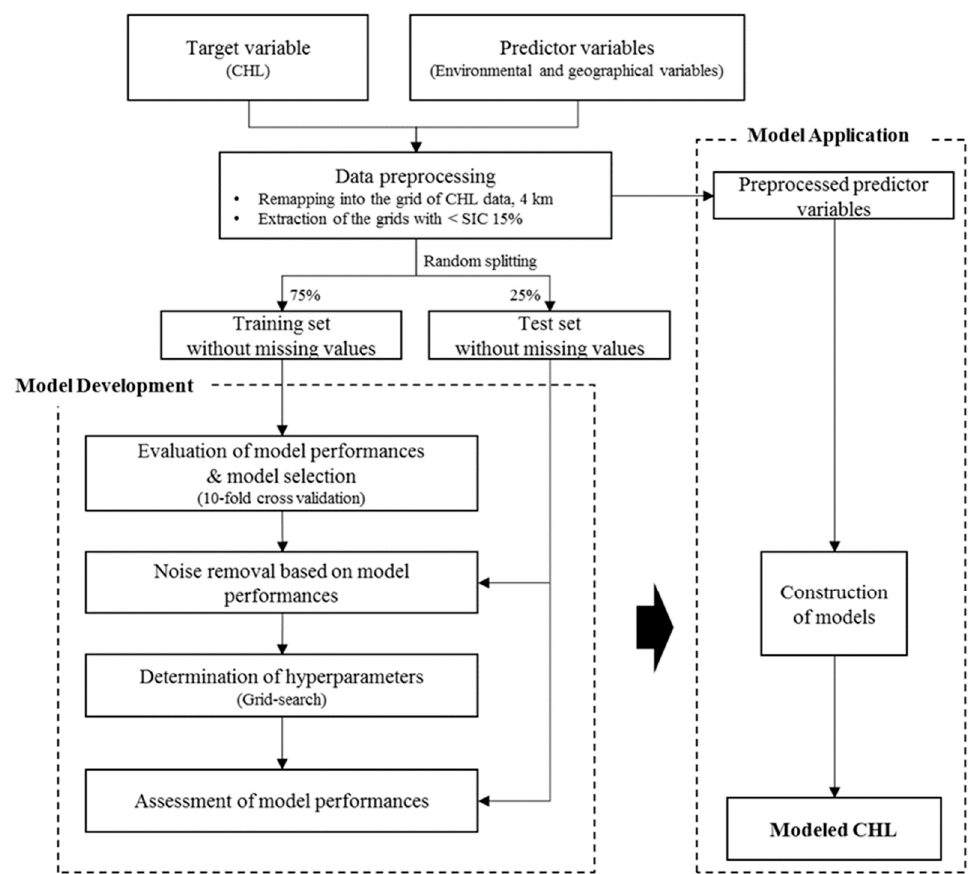
Figure 2. The workflow of the reconstruction of chlorophyll concentration (CHL) data using machine learning techniques.